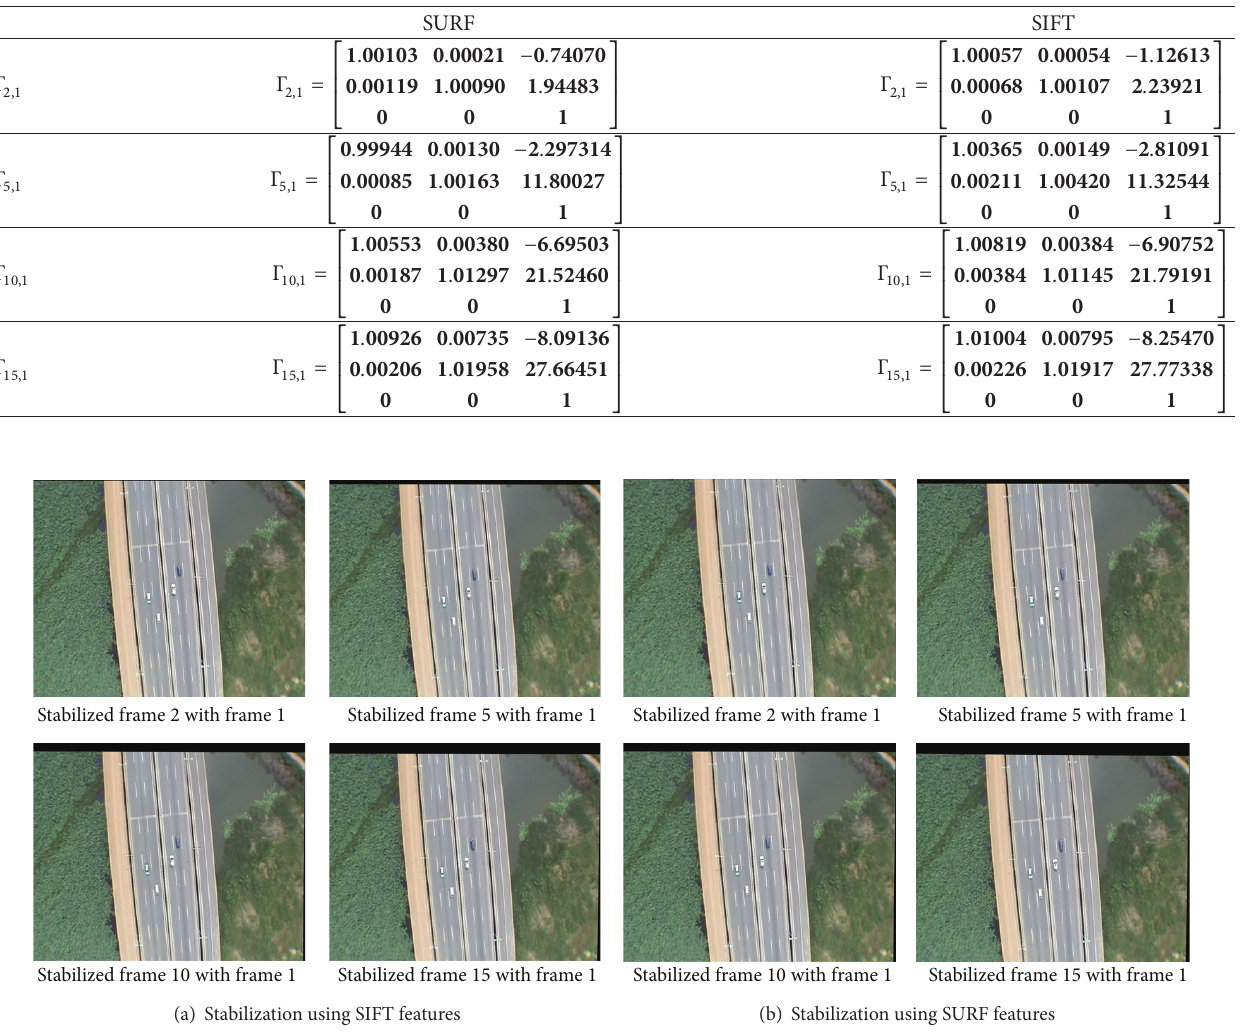
Figure 11: The 1st frame wrapped with the 2nd frame, 5th frame, 10th frame, and 15th frame, respectively, using SIFT features (a) and SURF features